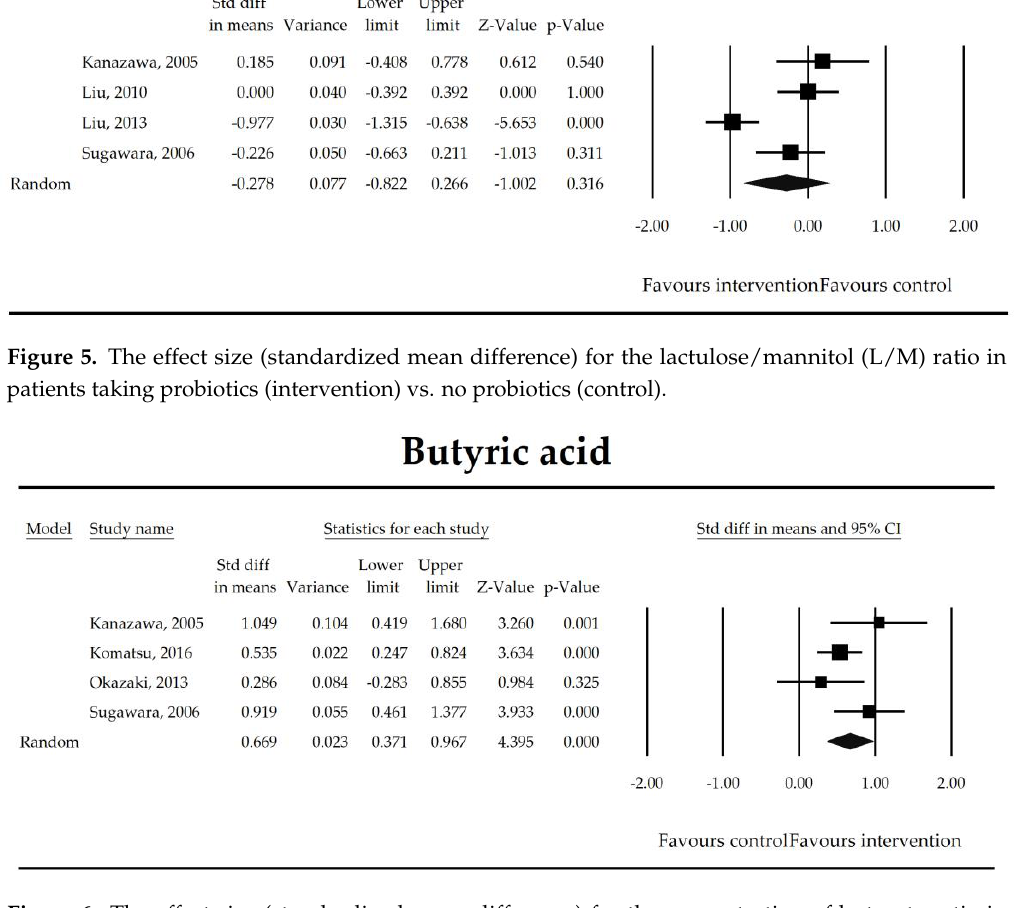
Figure 6. The effect size (standardized mean difference) for the concentration of butyrate ratio in patients taking probiotics (intervention) vs. no probiotics (control).